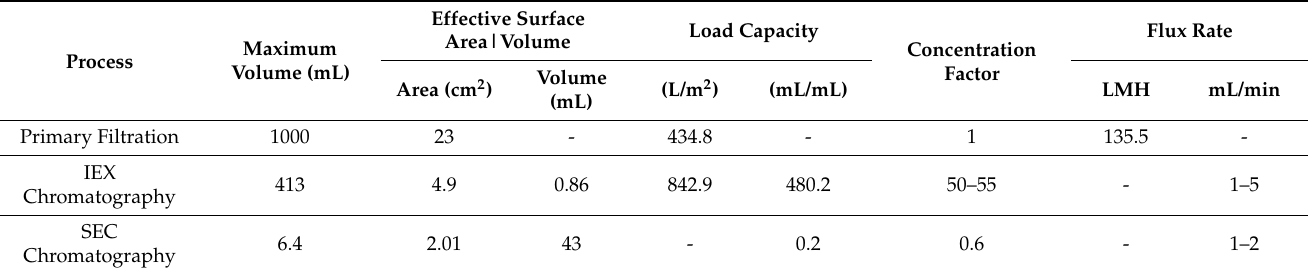
Table 3. Summary of process